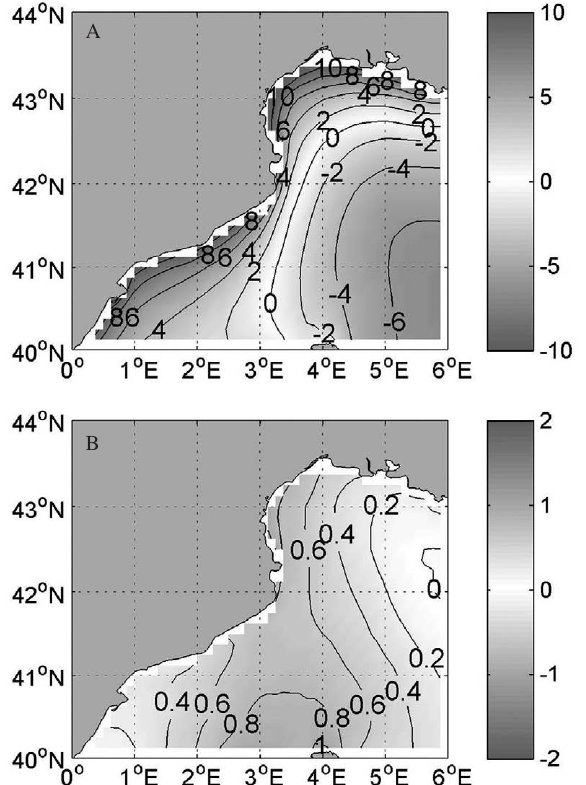
Fig . 3. – a, first spatial variance eof mode for the monthly mean sWH; B, second spatial variance eof mode for the monthly mean